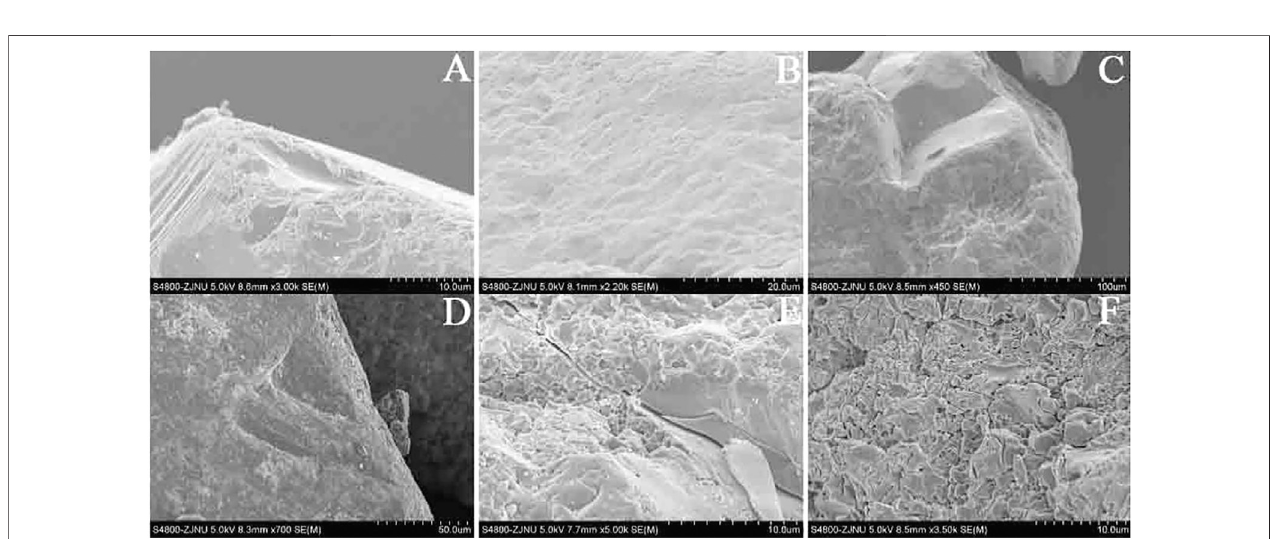
FIGURE 5 | (A) Conchoidal fractures. (B, C) V-shaped cracks. (D) Triangular cracks. (E) Solution crevasses. (F) Silica globules.